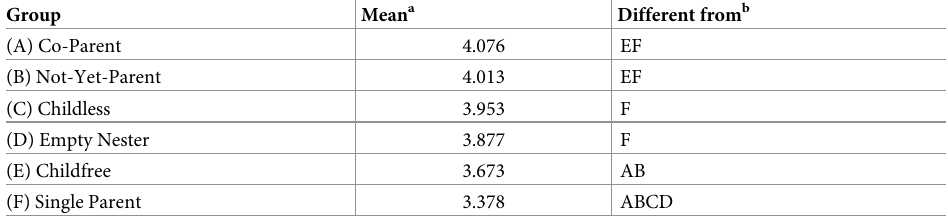
Table 4. Mean neighborhood